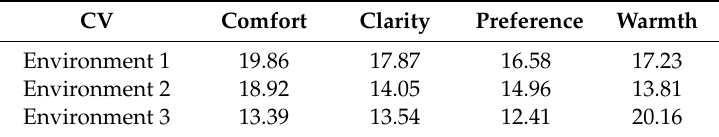
Table 2. CV for evaluating scores in di ff erent lighting environments.